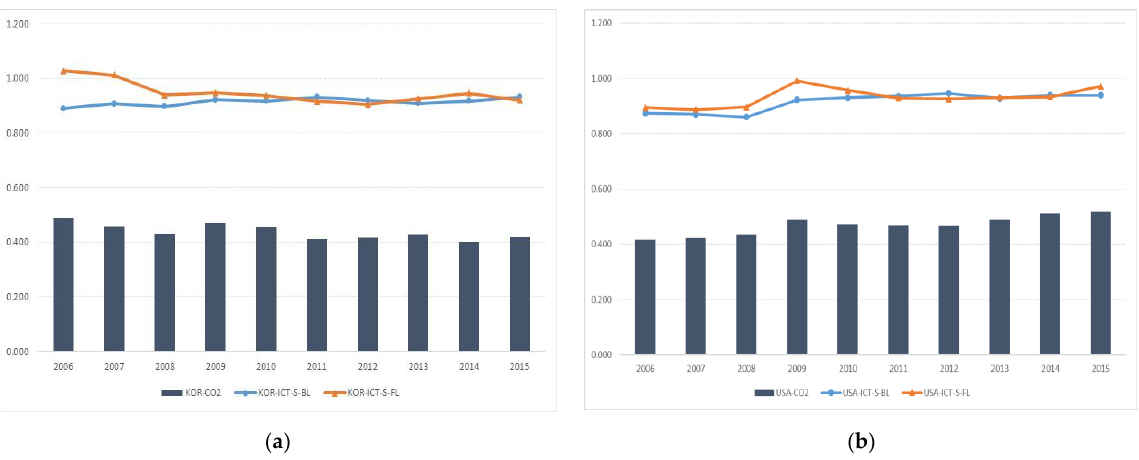
Figure 2. Trends of linkage effect and CO₂ emission of ICT service between Korea and USA: ( a ) Korea (2006–2015); ( b ) USA (2006–2015). Source: authors’ own computations on the data collected from OECD stat [45].